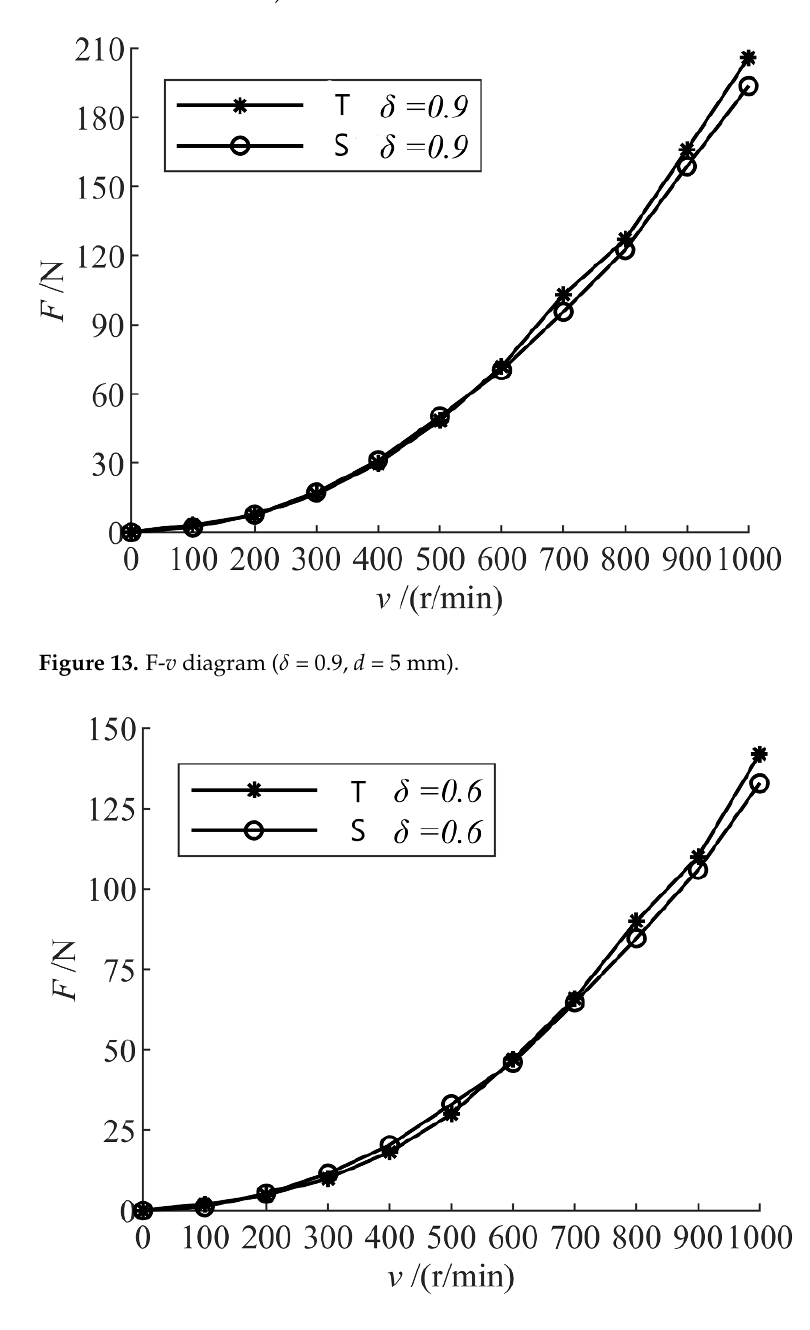
Figure 15. F- v diagram ( δ = 0.3, d = 5 mm).